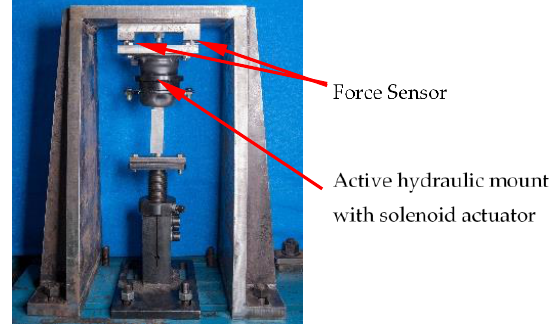
Figure 8. Experiment rig for the secondary path in AHM.